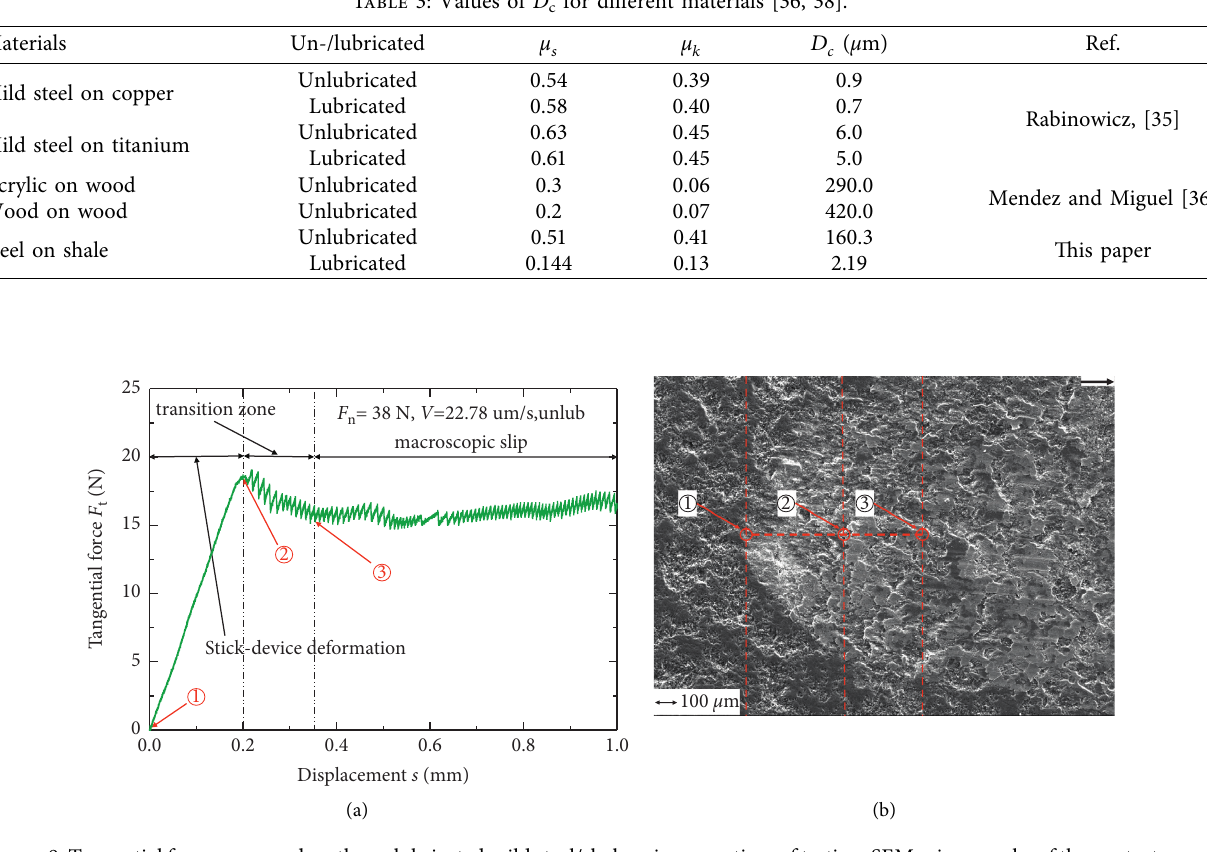
Figure 9: Tangential force measured on the unlubricated mild steel/shale pair versus time of testing. SEM micrographs of the contact area of the shale after different times of testing (arrows indicate the direction of tangential force